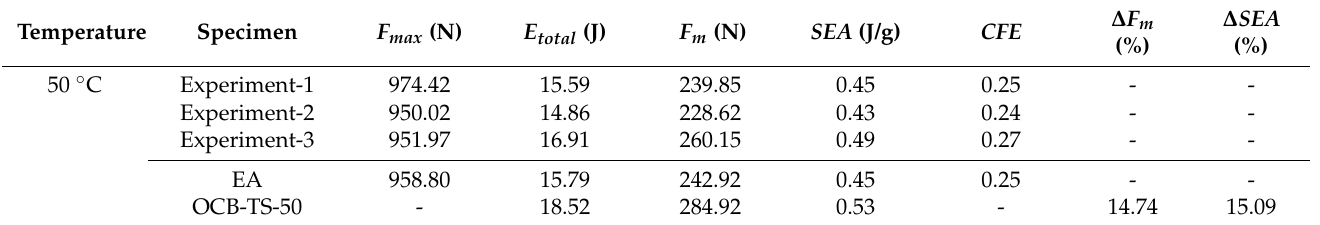
Table 7. In the quasi-static uniaxial compression experiment at 50 ◦ C, the energy absorption index of OCB, TS is the theoretical